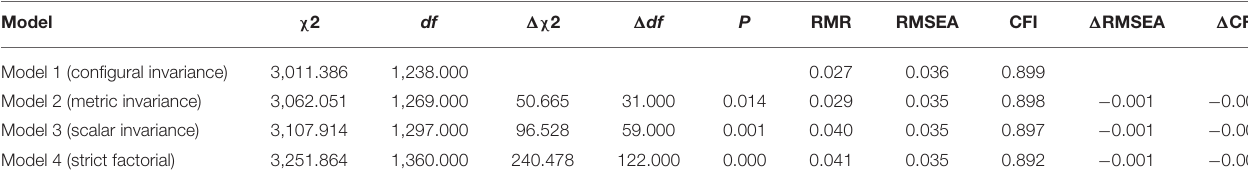
TABLE 7 | Multigroup CFA Fit indices for the preschool learning skills scale across gender ( n = 1,137). Model Model 1 (configural